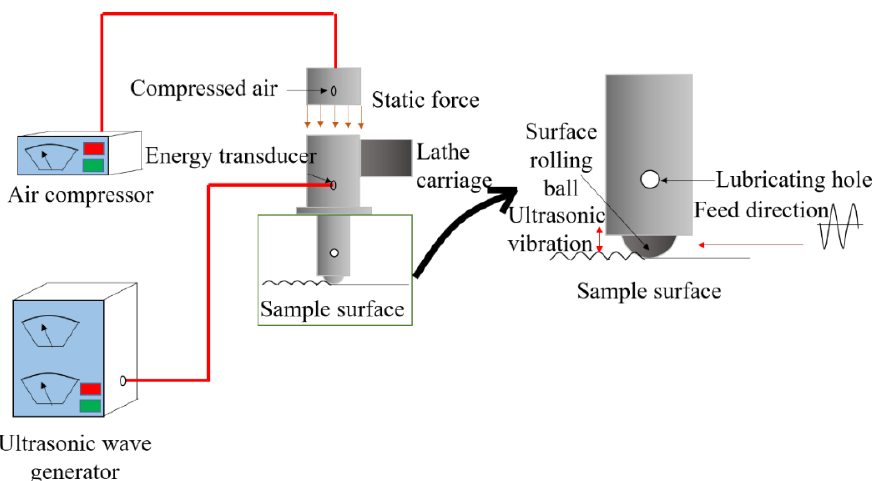
Figure 2. The fundamental working process of USRP.